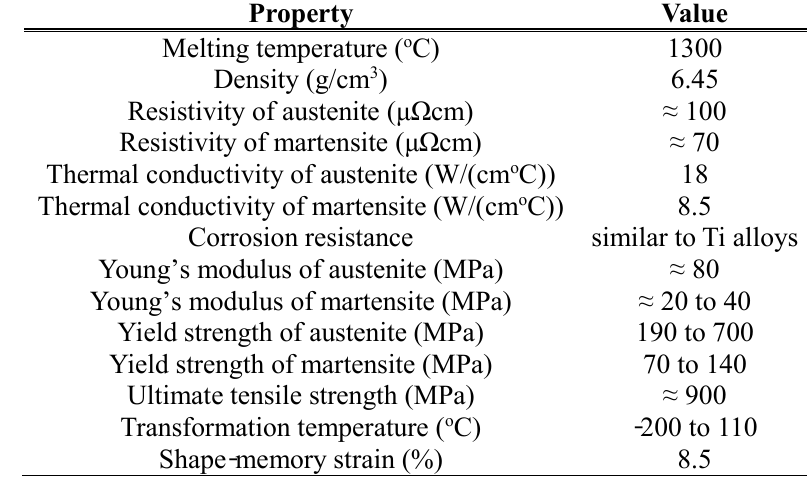
Properties of binary Nitinol SMAs.